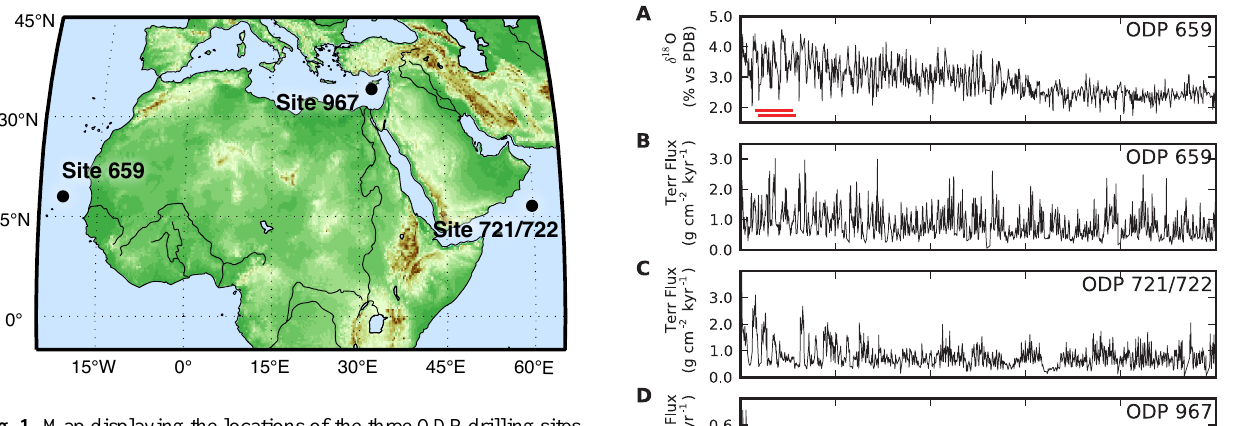
Fig. 1. Map displaying the locations of the three ODP drilling sites considered in this study (Tiedemann et al., 1994; deMenocal, 1995, 2004; Larrasoa˜na et al., 2003).